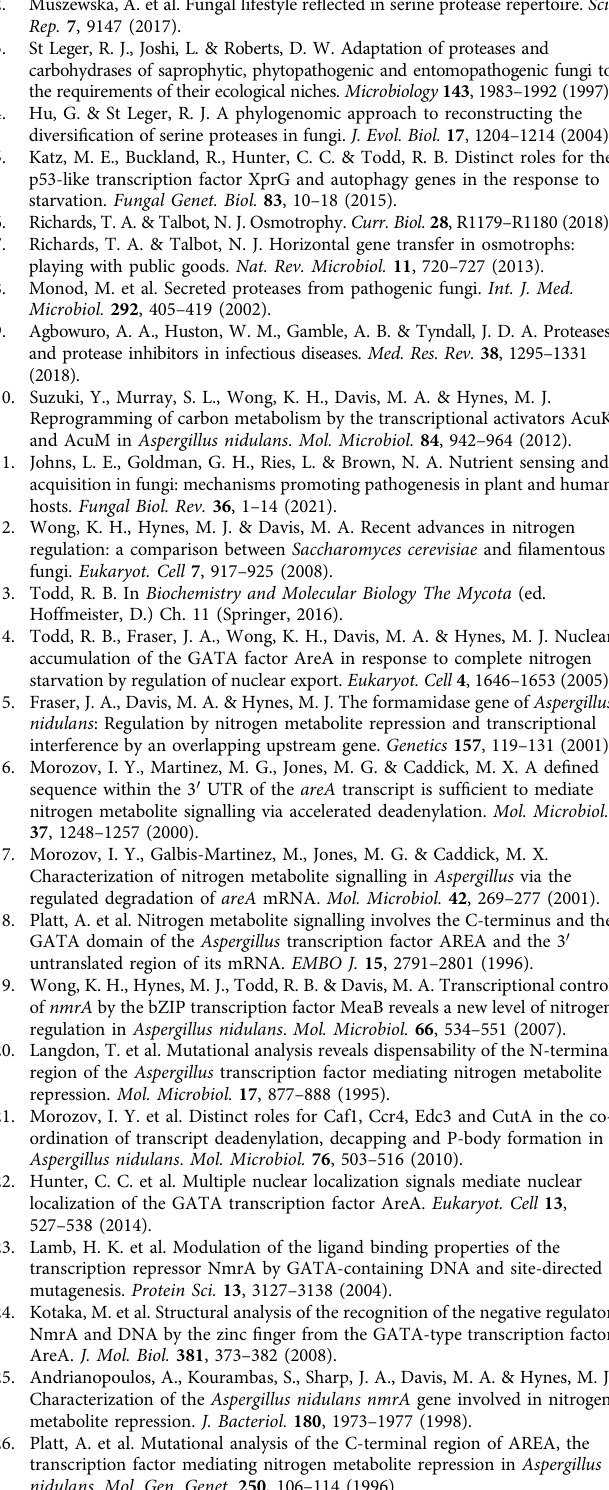
Table 3. IP ef fi ciency was calculated for each gene by comparing the amount between IP product and input DNA. Open reading frame-free region was used as background control to compare the IP ef fi ciency between different genes and samples. Library preparation for PolII ChIP-seq analysis was carried out as described previously 41 . Sequencing was performed on Illumina HiSeq2500. Raw reads were mapped to A. nidulans genome version A_nidulans _FGSC_A4_ver- sion_s10-m04-r03 using Bowtie2 42,43 . PolII ChIPseq signals were calculated by fi rst summing the total number of reads overlapping at each base pair across the